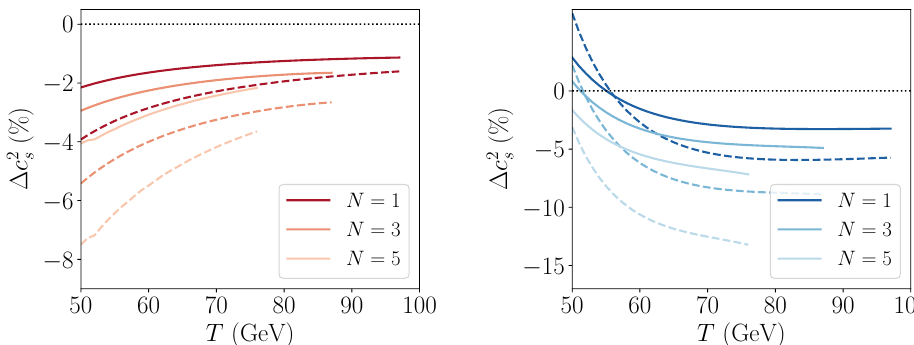
Figure 6 . Sound speed as a function of temperature in the singlet (left) and the Higgs phases (right). The solid lines correspond to the case with all fermionic families ( N f = 3 ) for N = 1 , 3 , 5 , and dashed lines show result with only one fermionic family ( N f = 1 ). The endpoints of the graphs are set by the critical temperature T c,φ